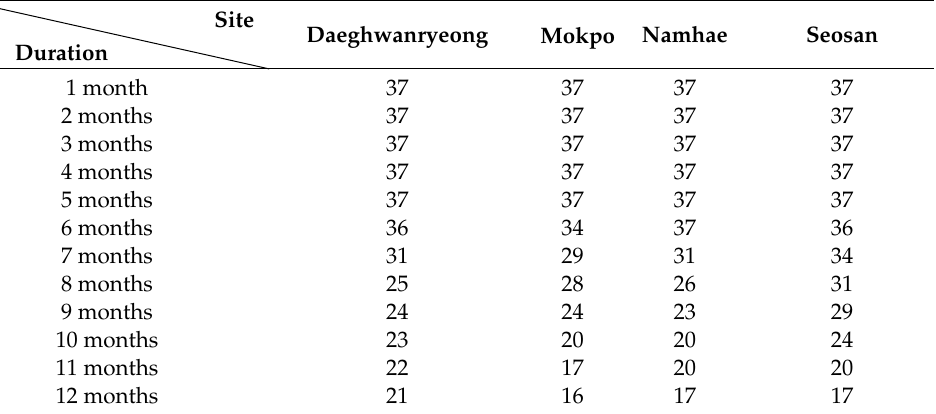
Table 1. Number of partial duration series.